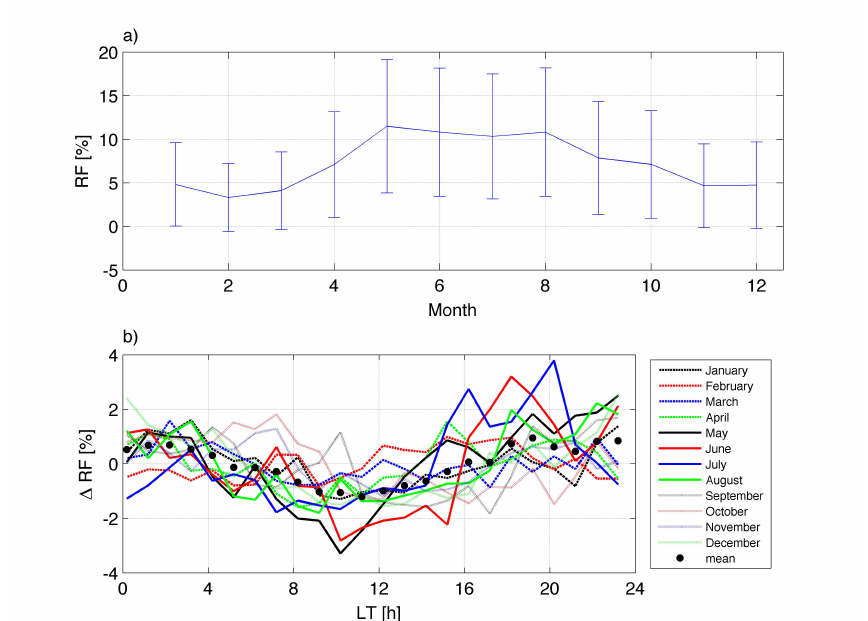
Figure 9. ( a ) seasonal variation in rain fraction (defined in the text) observed by the TROWARA radiometer in Bern from 2004 to 2016. The error bars indicate the standard deviation of the monthly mean from year to year. ( b ) seasonal dependence of the diurnal cycle in rain fraction ∆ RF (for ILW as a function of local time over Bern for the time interval 2004–2016. The panel shows ∆ RF = (RF − monthly mean of RF). The black dots indicate the annual mean of the seasonal